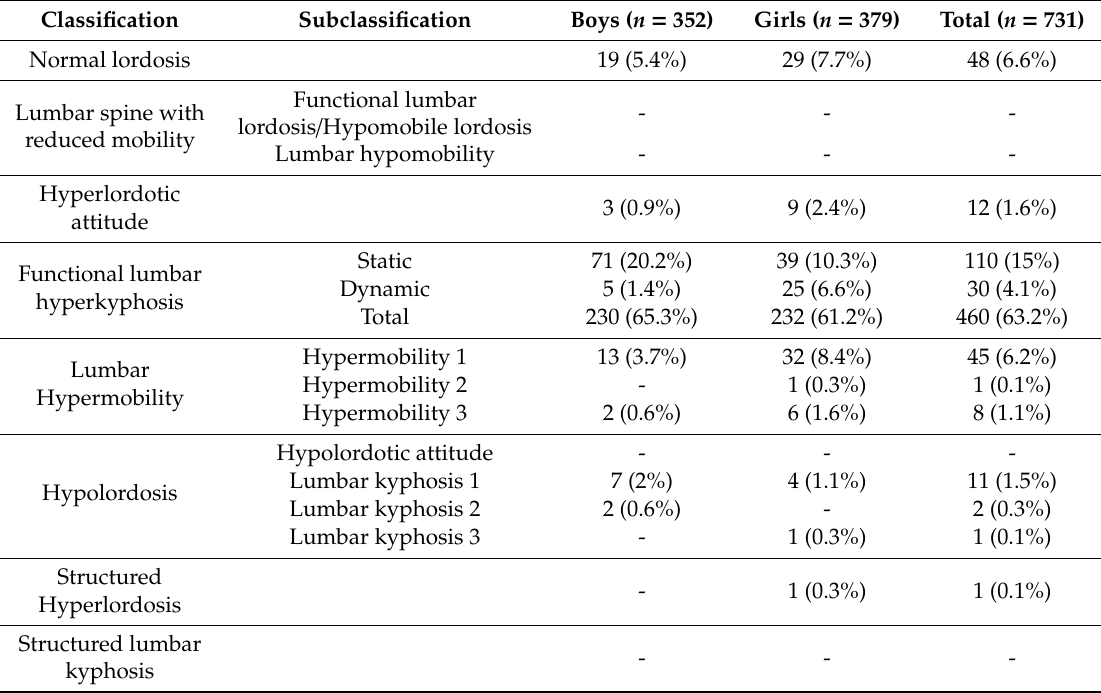
Table 6. Absolute and relative frequency of children in each classification and subclassification of “Sagittal Integral Morphotype” for the lumbar